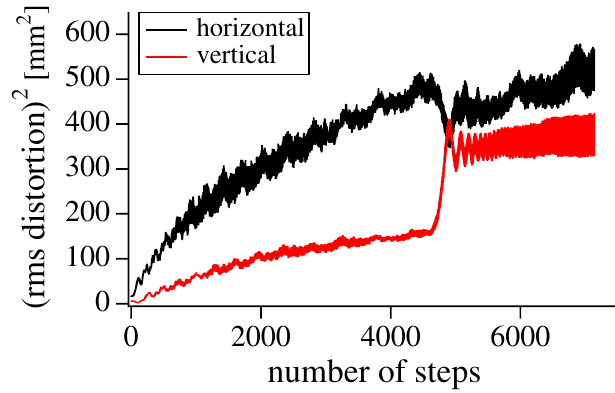
FIG. 14. (Color) Evolution of the square of horizontal and vertical rms orbit distortion when acceleration rate is 5 times slower. Exchange of distortion occurs when a particle crosses qx (cid:1) 2 qy (cid:2) 0 resonance.